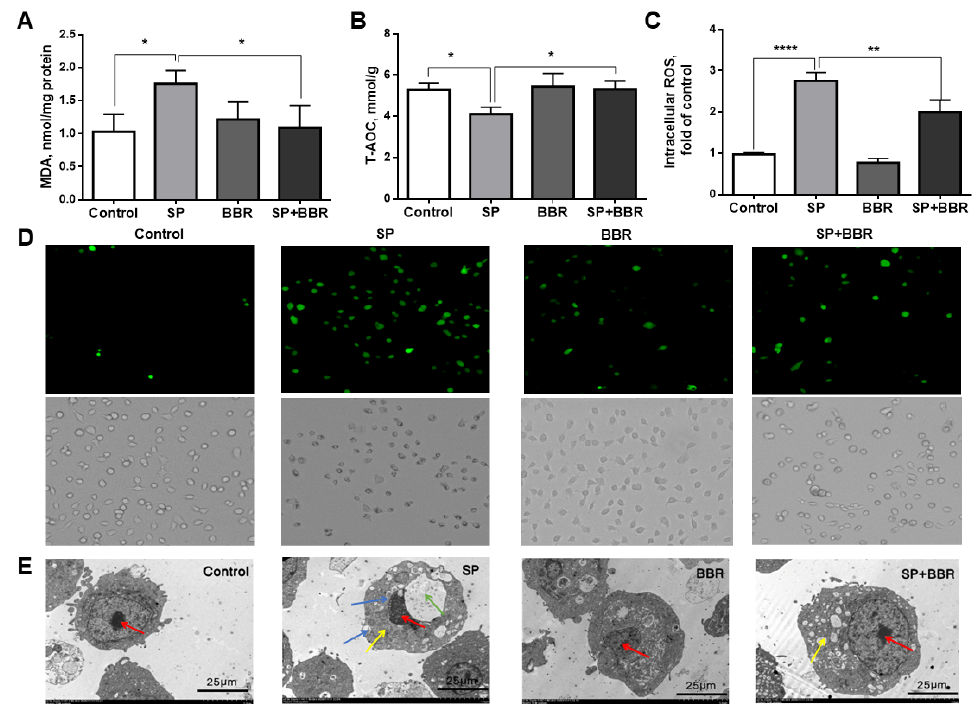
Figure 1. Indicators of oxidative stress in different treatment groups within ZFL and transmission electron microscopy pictures of ZFL. ( A ) is MDA (malondialdehyde). ( B ) is T-AOC (total antioxidant capacity). ( C ) is the relative expression of ROS. ( D ) is the ROS fluorescence microscope picture. The red arrow is the fluorescence of ROS in zebrafish liver cells. The higher the ROS content, the stronger the fluorescence intensity. Dates were presented as mean ± SEM ( n = 3). * p < 0.05, ** p < 0.01, and **** p < 0.0001. ( E ) shows transmission electron microscopy pictures of ZFL. The red arrow is the nucleus, the blue arrow is the lipid drop, and the yellow arrow is the mitochondria, the green arrow is bubbles.